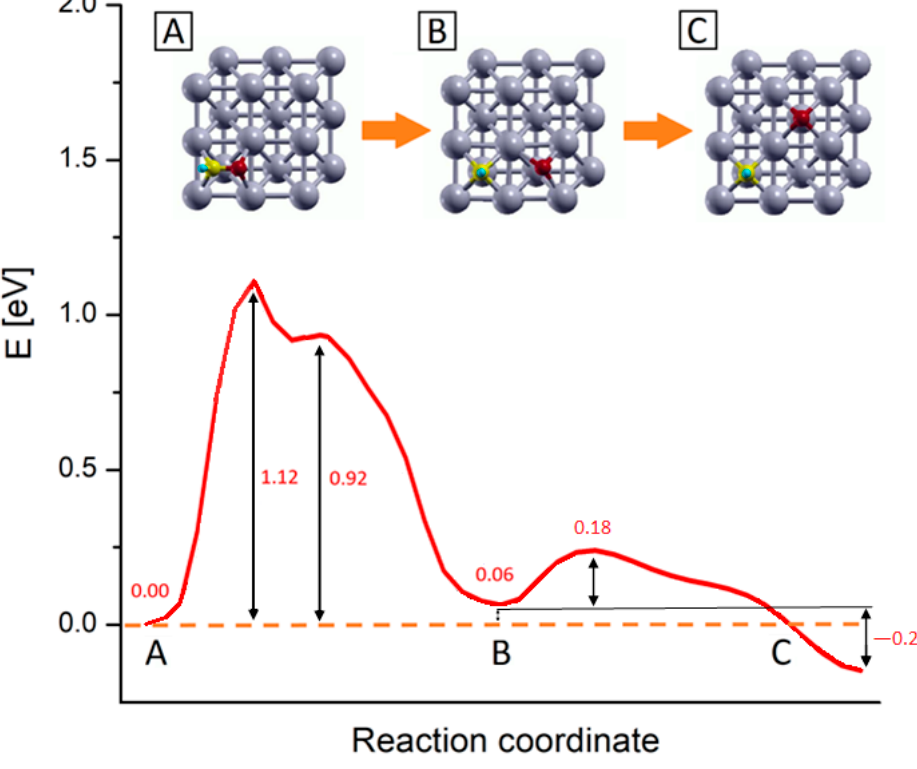
Figure 4. PBE+U computed reaction energy profiles for the CHO* → CH* + O* step on Rh (100) surface. The numbers report the values of energy barriers and reaction energies in eV. Inset pics represent the main step of the process: ( A ) CHO* most stable configuration, ( B ) configuration of dissociated species, and ( C ) equilibrium configuration of the dissociated species upon oxygen diffusion. Yellow, red, light blue and grey represent C, O, H and Rh atoms respectively.